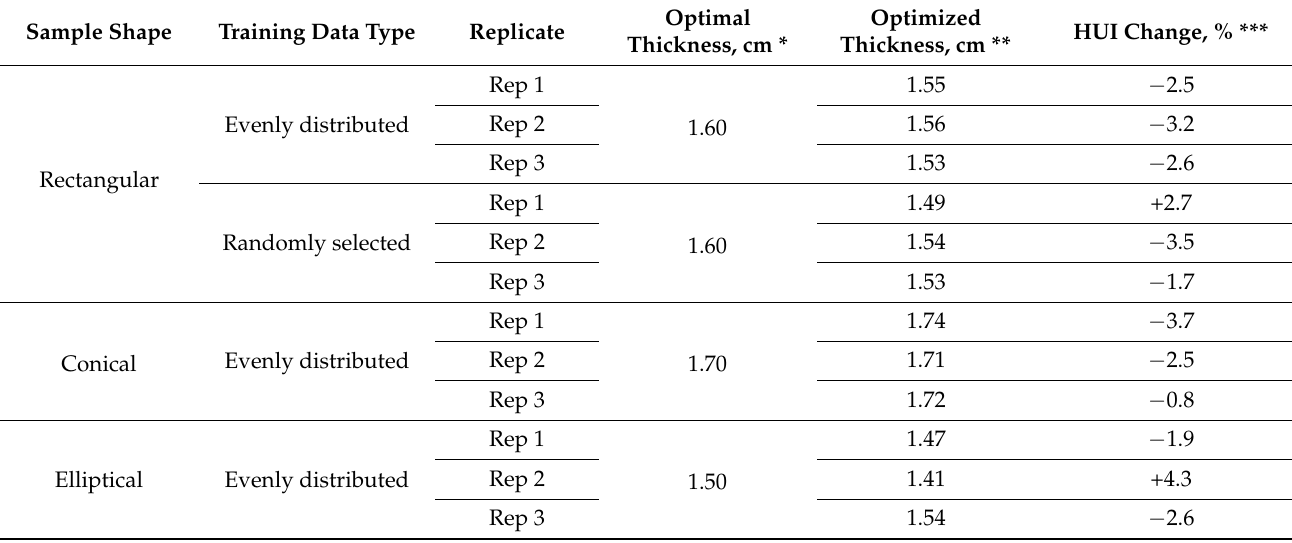
Table 2. Summary of the optimized thickness using the integrated approach and corresponding HUI change compared with the parametric sweep